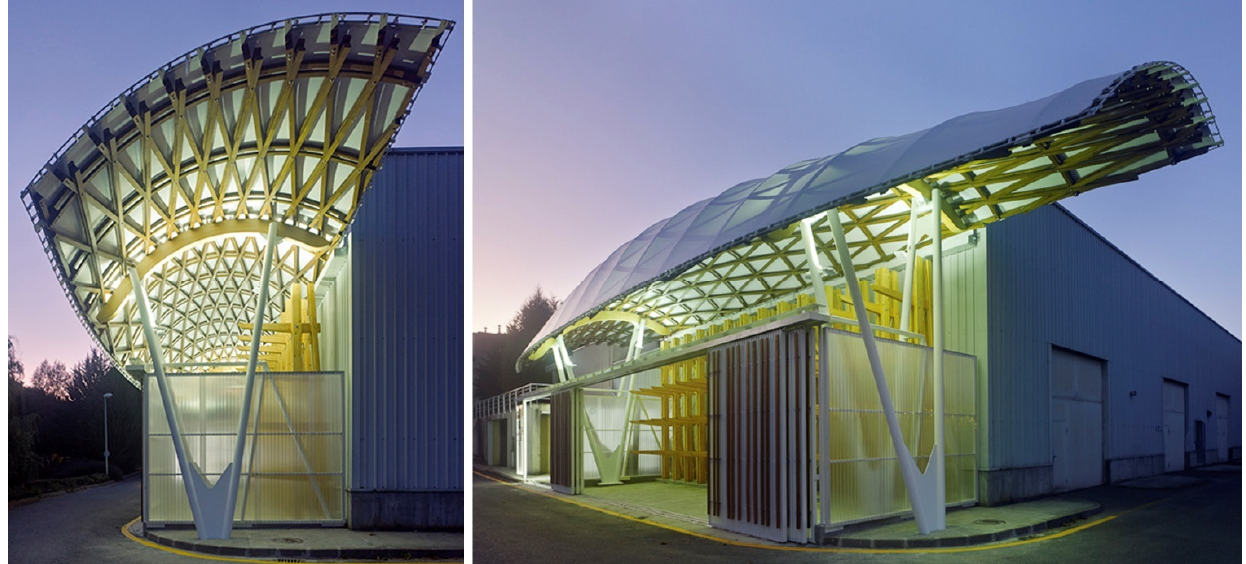
Figure 1. Exterior views of PEMADE gridshell.